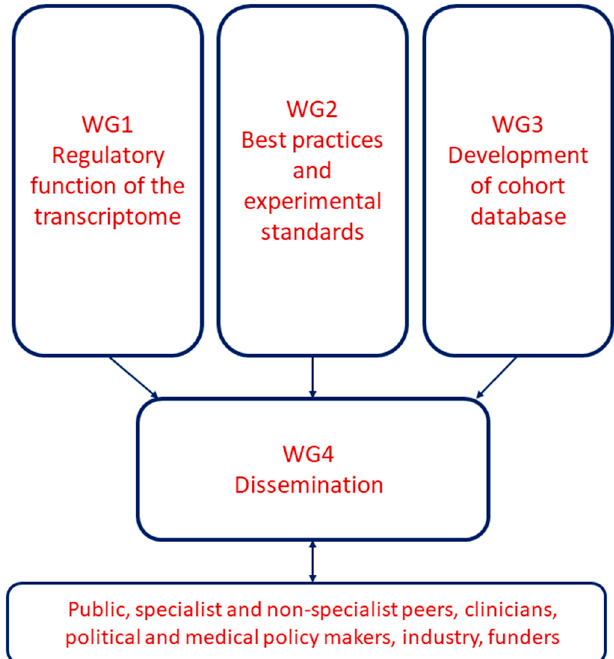
Figure 1. EU-CardioRNA Working Group organisation .